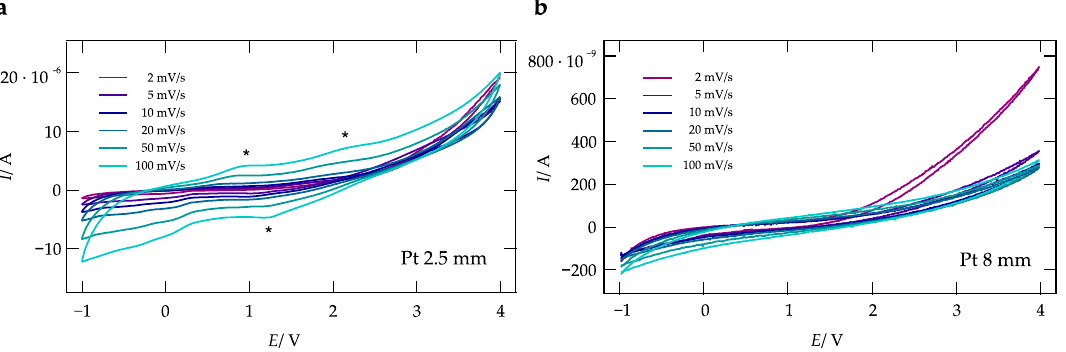
Figure 7. CVs of a La 0.9 Ba 0.1 F 2.9 cell with two Pt electrodes. The diameter of the WE was either 2.5 mm ( a ) or ( b ) 8 mm. CVs were recorded at scan rates ranging from 0.002 V/s to 0.1 V/s at 200 ◦